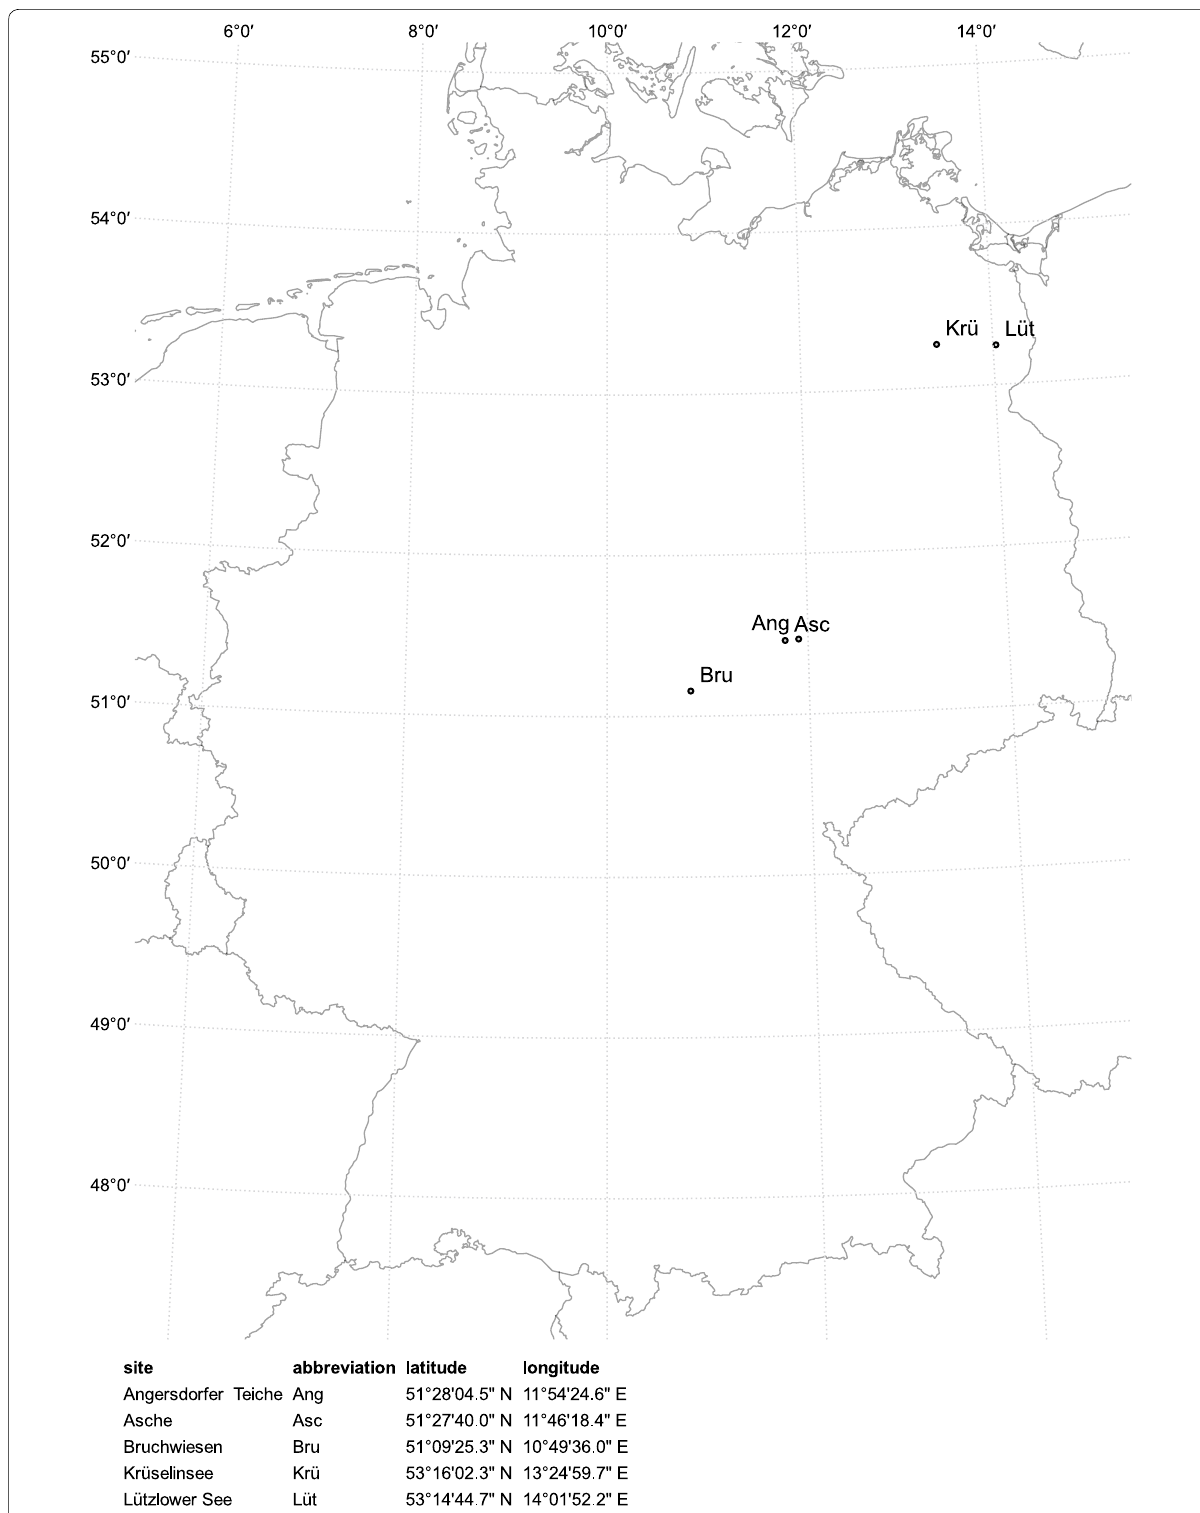
Fig. 1 Map of investigated sampling sites (QGIS version 3.2, GeoBasis-DE/BKG 2018). Sites are abbreviated as first three letters: Krüselinsee (Krü), Lützlower See (Lüt), Angersdorfer Teiche (Ang), Asche (Asc) and Bruchwiesen